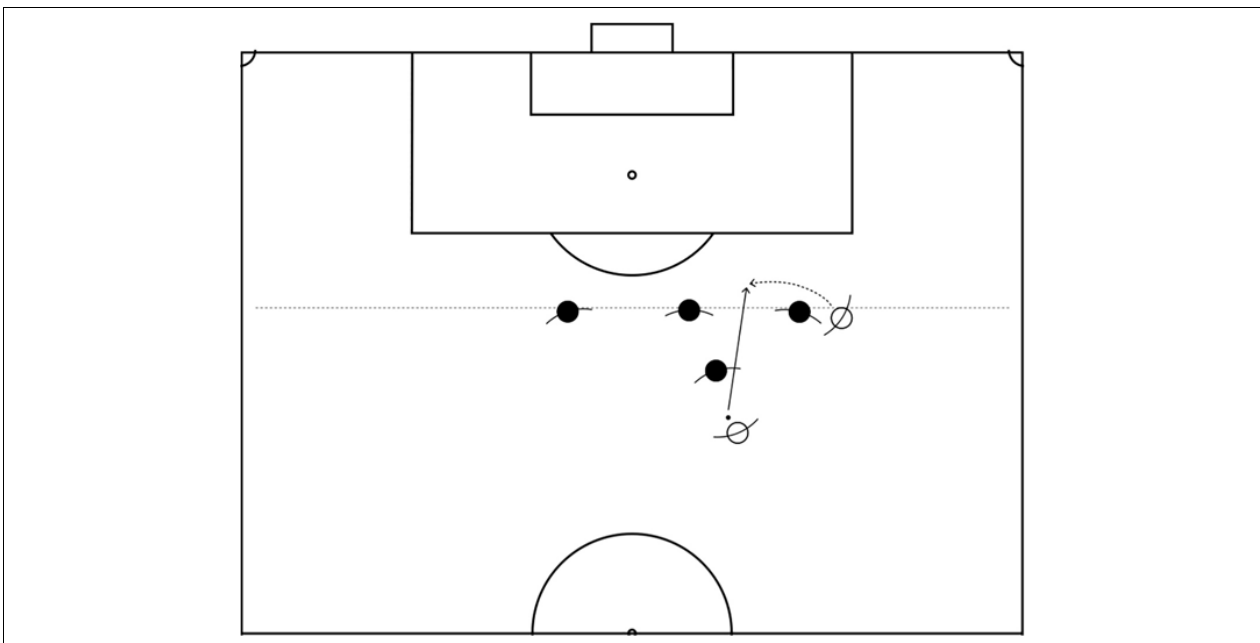
FIGURE 2 | Seeking for the pass in the back of the defense